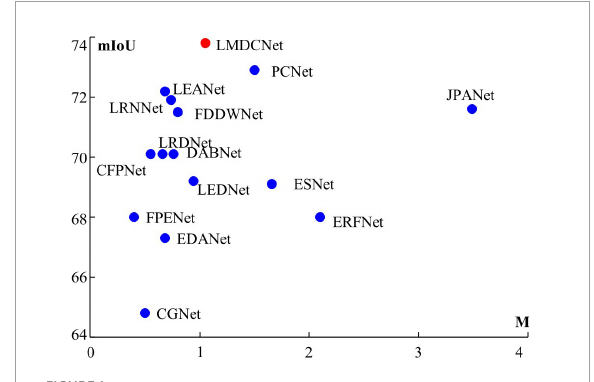
FIGURE1 Accuracy of segmentation (mIoU) and network parameters (M) derived from Cityscapes test set. Clearly, our LMDCNet achieves the optimal balance between segmentation accuracy and